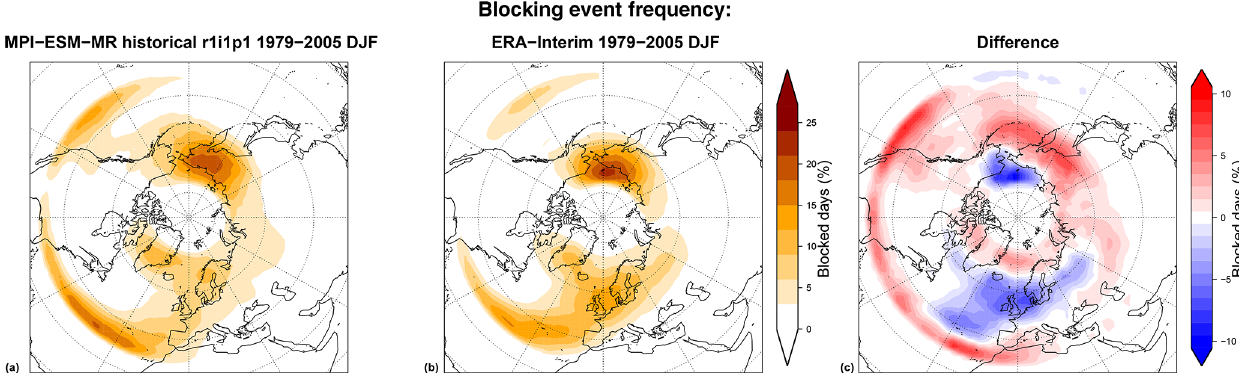
Figure 10. Two-dimensional blocking event frequency (percentage of blocked days) following the Davini et al. (2012) index over the 1979– 2005 DJF period for (a) the CMIP5 MPI-ESM-MR historical r1i1p1 run, (b) the ERA-Interim Reanalysis, and (c) their differences. Produced with recipe_miles_block.yml ; see details in Sect.